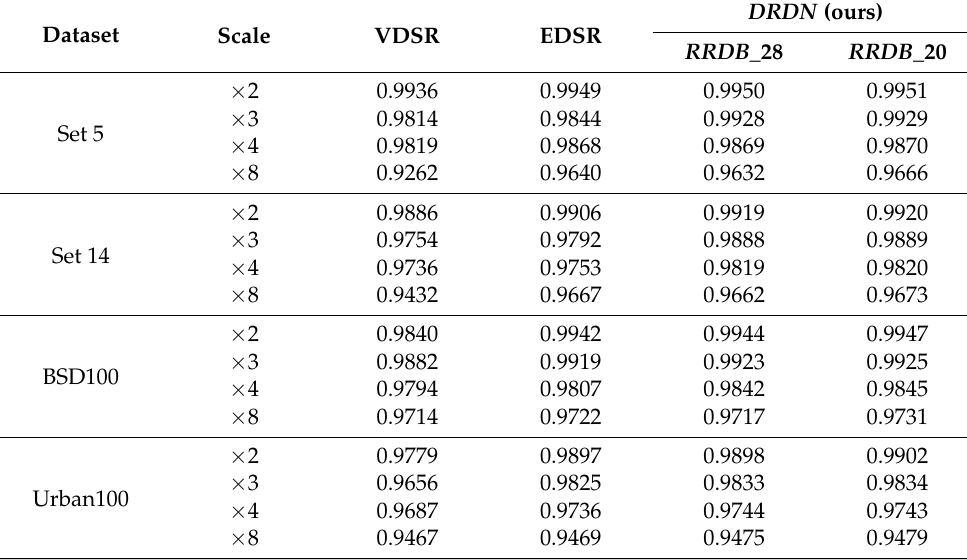
Table 3. Universal image quality index ( UQI ) evaluation based on benchmark